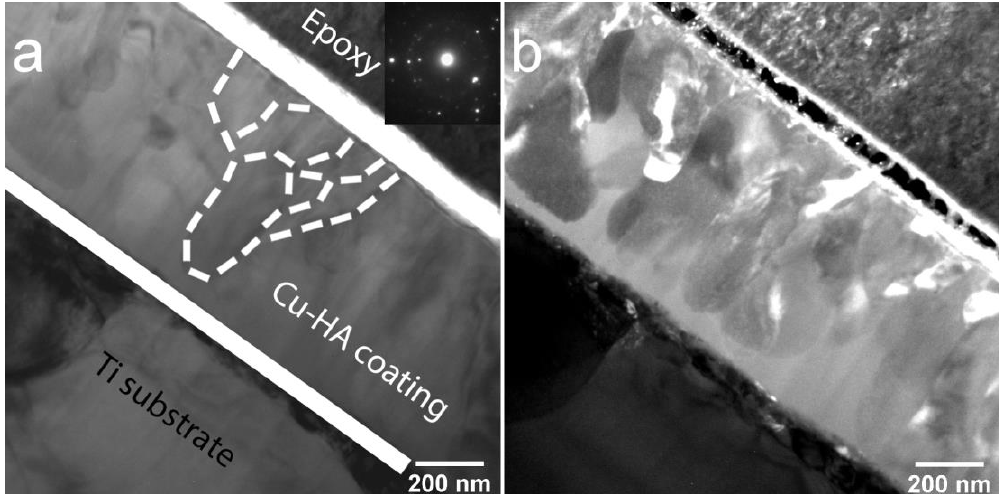
Figure 5. Transmission electron microscope (TEM) image of the cross-section of Cu-HA coating on Ti after HT at 450 °C bright field (BF), the inset shows the corresponding electron diffraction pattern ( a ) and dark field (DF) ( b ).